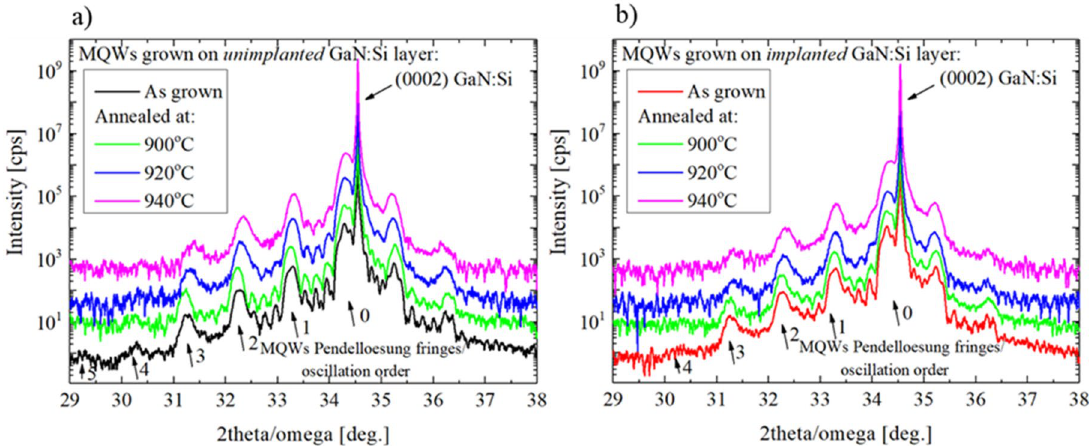
Figure 10. HRXRD 2theta/omega scans for the MQWs grown on unimplanted ( a ) and implanted ( b ) GaN:Si layer and after annealing at 900 °C, 920 °C and 940 °C.